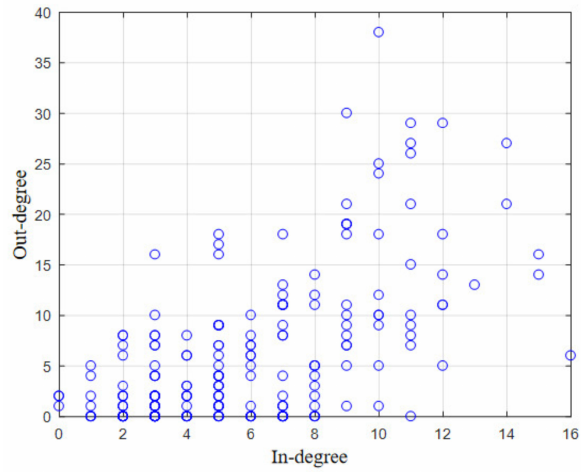
Figure 17. Relationship between airport in-degree and out-degree.